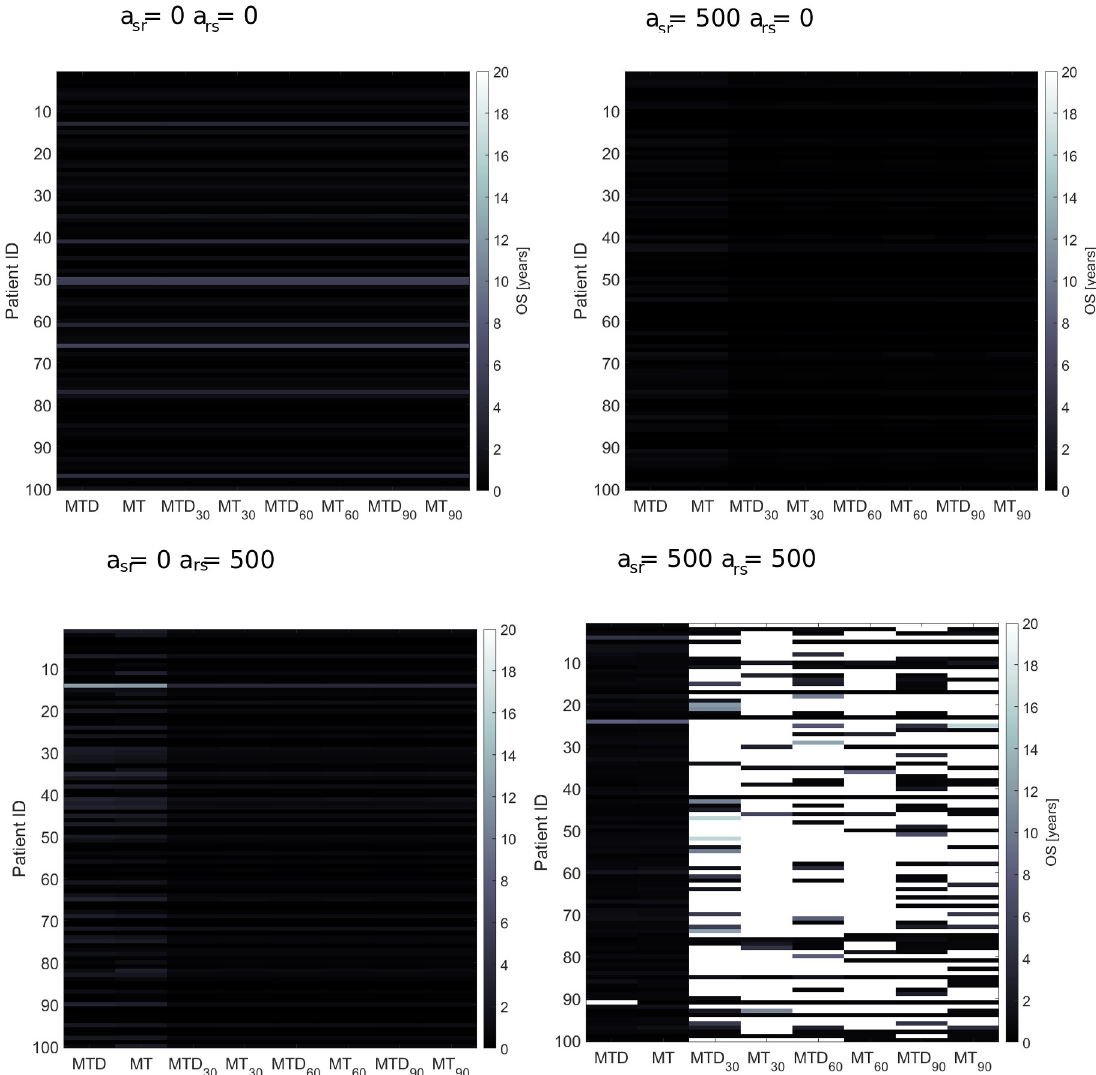
Fig 6. Comparison of all eight chemotherapy treatment schedules. For four combinations of a sr and a rs , the heatmap shows the long- term response (represented by the colors) to palliative chemotherapy administered using eight different schedules. On x-axis we have different patient schedules and on y-axis patient ID. Optimal treatment schedule depends on dynamics of competition between various subclones in a tumor. For example, for high a sr and a rs , the best outcome gives schedules with drug holidays, whereas for weak competition all schedule gives the same